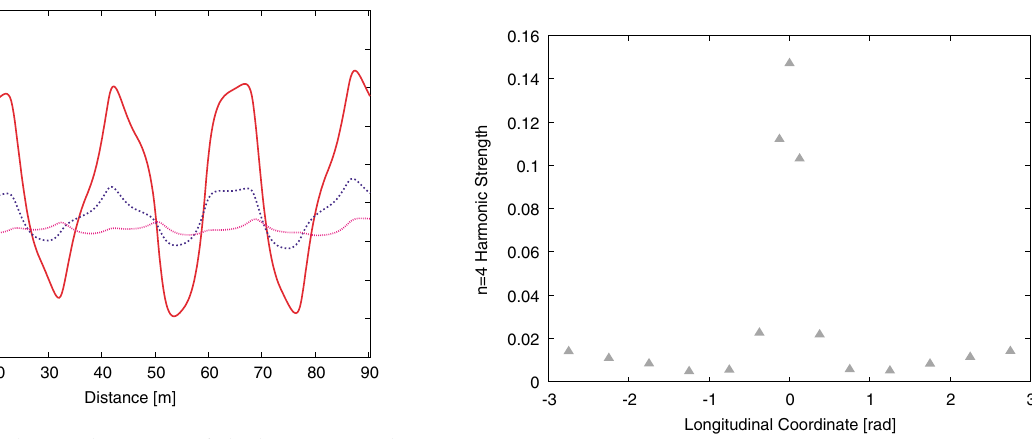
FIG. 7. Strength of the (cid:4) longitudinal coordinate. The harmonic strengths are obtained (red solid via FFT of the second moments of the beam at specific l (pink dotted line). longitudinal locations. l